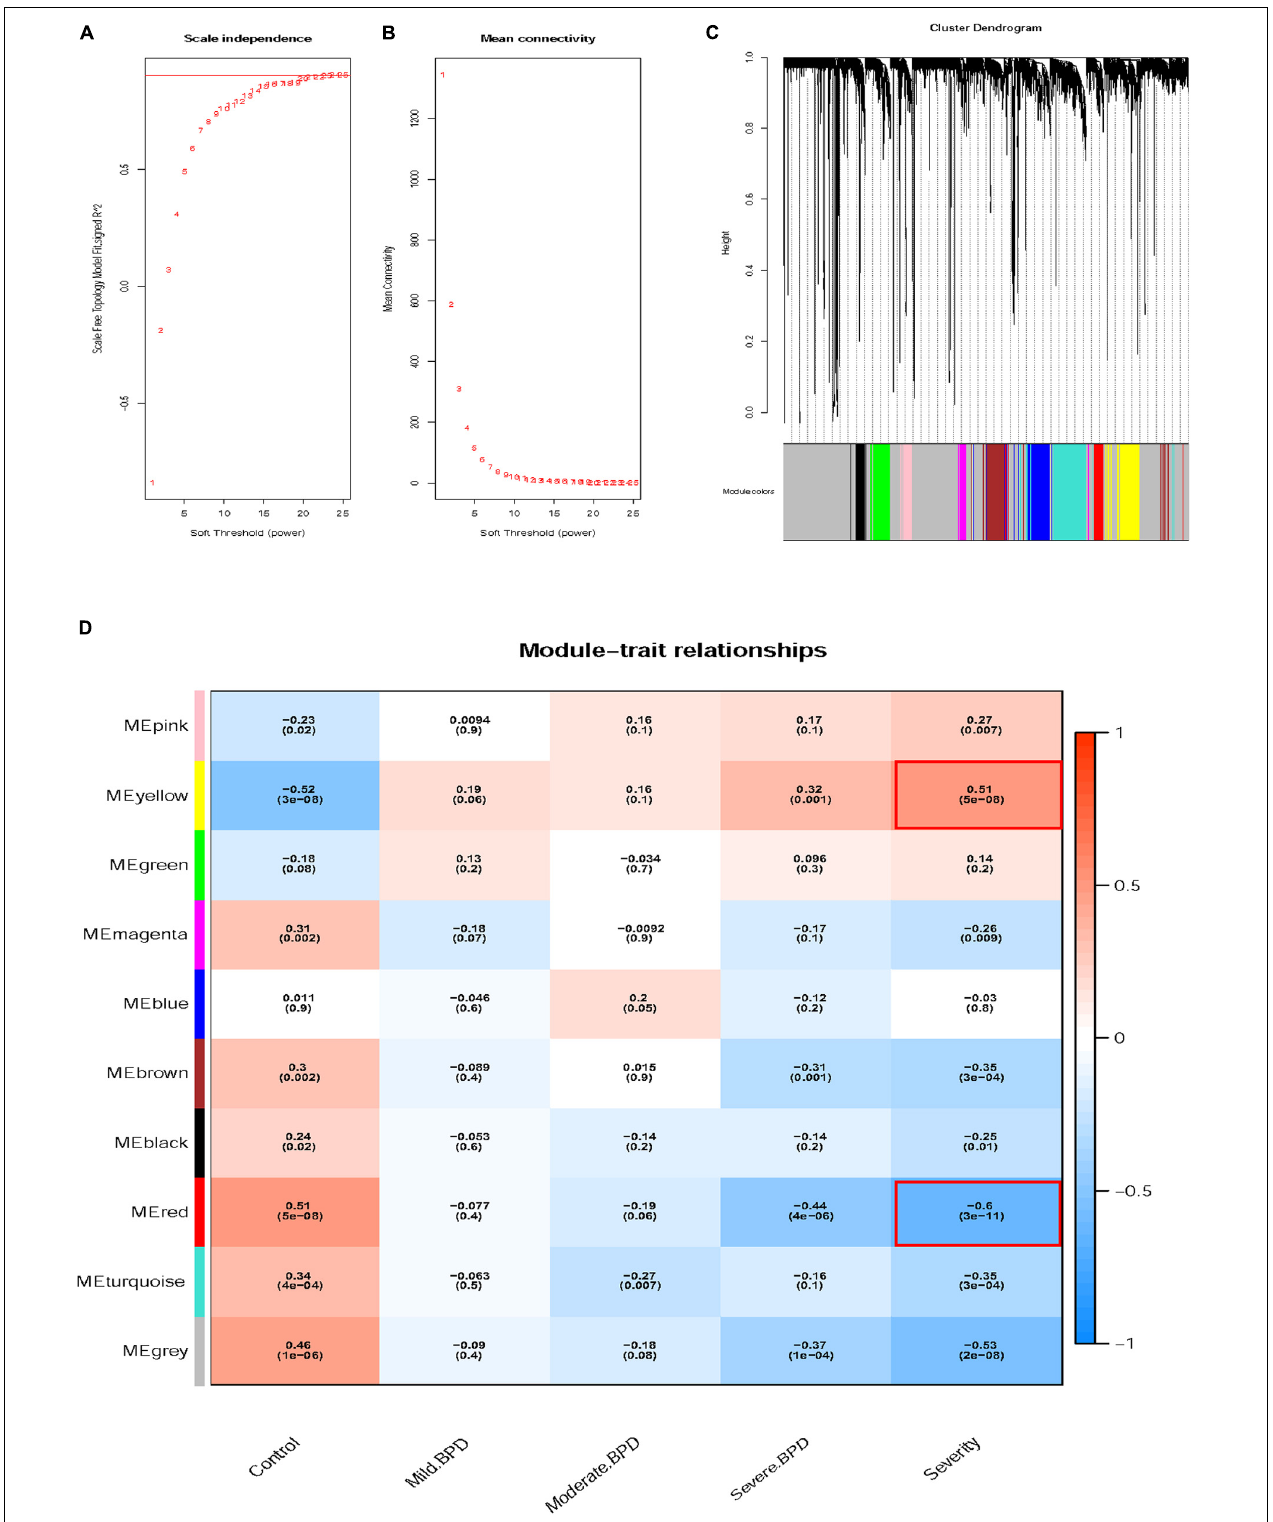
FIGURE 3 | Determination of soft-thresholding power and grouping of genes with similar expression into modules using weighted gene co-expression network analysis (WGCNA). (A) Analysis of the scale-free fit index for soft-thresholding powers ( β ). (B) Analysis of the mean connectivity for soft-thresholding powers. (C) Dendrogram of clustered genes. (D) Identification of modules associated with clinical information.